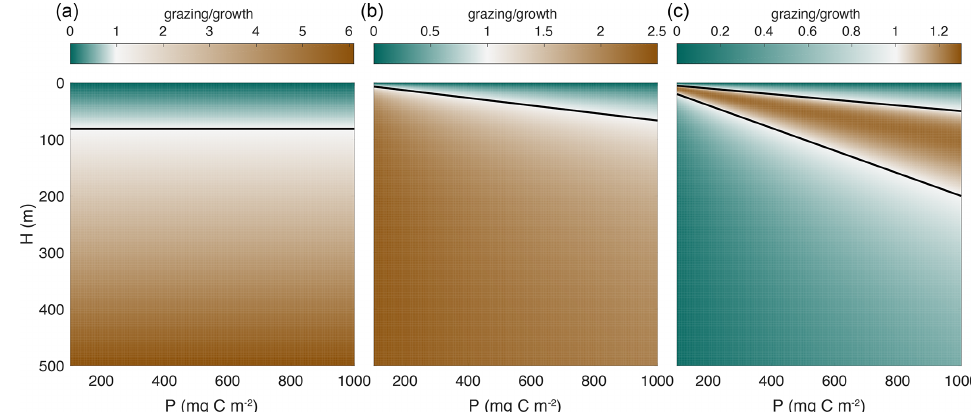
Figure 2. Ratio of grazing to growth as a function of phytoplankton biomass and mixed layer depth for mixed layer integrated models, e.g., Eq. (4). The black line separates regions where growth is faster than grazing (greens) from regions where grazing is faster than growth (browns). Note the different color scales in each panel. The parameter values used and the expressions for each functional type are given in Table 1. (a) Holling type I (linear). (b) Holling type II (saturating). (c) Holling type III (inflection at low concentrations). The zooplankton concentration ( z 0 ) used in panel (a) is 0.5mgCm − 3 , and the zooplankton biomass ( Z ) used in panels (b) and (c) is 100mgCm − 2 . It is well-established that growth dominates over grazing when the mixed layer is shallow due to increased light availability. In the case of the Holling type I functional response (a) , the black line is the critical depth, which is independent of phytoplankton biomass. Note that if a constant value of zooplankton biomass rather than concentration is used, the ratio of growth to grazing using the Holling type I functional response is constant as in Eq. (9). The switchover between growth to grazing dominance depends on phytoplankton concentration in the case of a Holling type II functional response and therefore on the combination of mixed layer depth and phytoplankton biomass. Only in the case of Holling type III functional response is there also a decrease in the grazing rate as the mixed layer depth